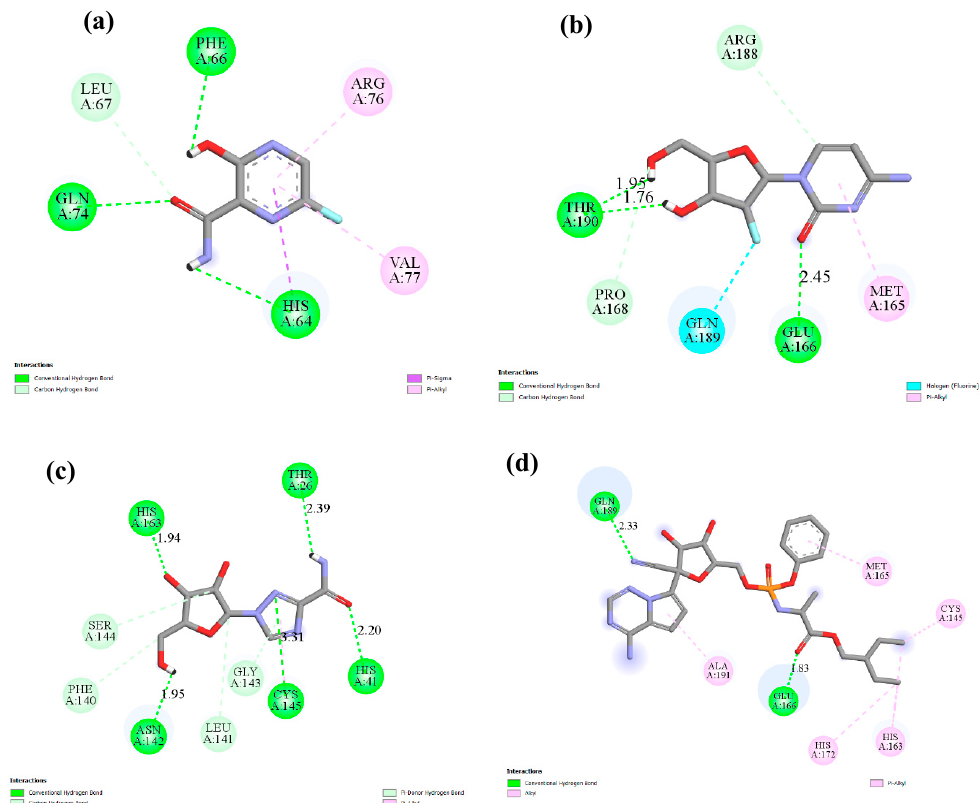
Figure 5. The interacting mode with SARS-CoV-2 M pro in 2D representations in complexes with ligand 1 ( a ), 3 ( b ), 4 ( c ) Remdesivir ( d ).